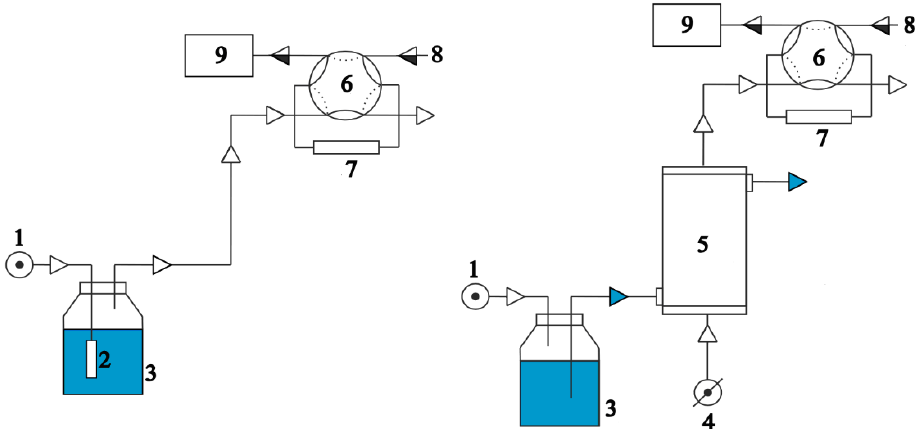
Figure 1. Schematic diagrams of the experimental setup used for dynamic HSA ( left ) and for continuous chromatomembrane HSA ( right ) with absorption of the gas extractant in both cases. 1: car- rier gas flow regulator; 2: gas sparger; 3: sample vessel with an aqueous solution of VOCs; 4: gas-